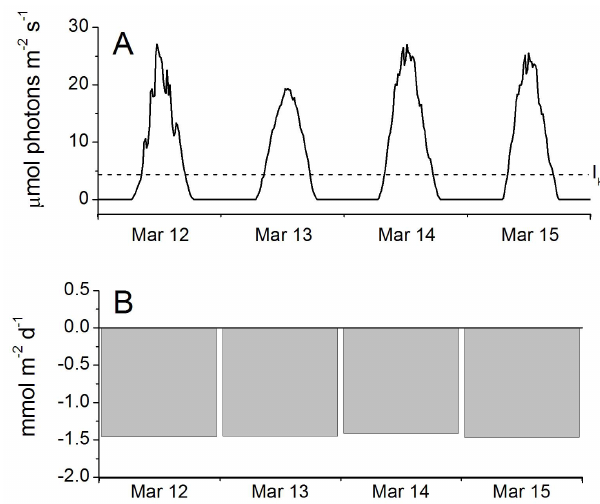
Fig. 7. (A) shows four days of irradiance measured immediately be- low the sea-ice. The dashed line is the I k value determined from the P/I curve and indicates that light saturation is present over much of the daylight hours. (B) shows the 24h integrated O 2 fluxes cal- culated from the irradiances in (A) and Eqs. 3 and 4. The small variations between these daily O 2 fluxes resulted from the ice algae being light saturated over most of the